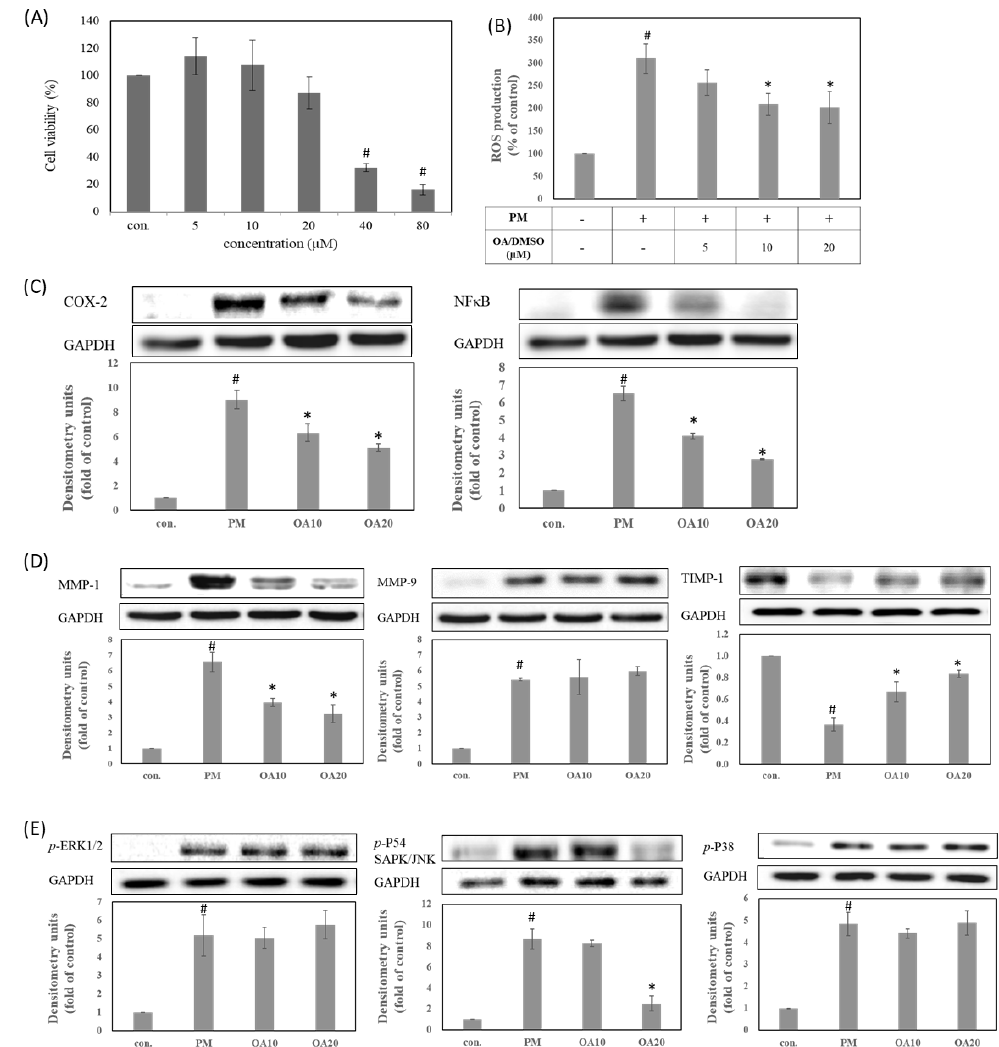
Figure 1. Oleanolic acid inhibits protein expression related to inflammation and aging in PM − induced keratinocytes damage through the ROS/MAPKs pathway. ( A ) Cell viability, ( B ) ROS production, ( C ) COX-2 and NF- κ B, ( D ) MMP and TIMP protein expression, and ( E ) phosphorylation of MAPKs. # represents p < 0.05 when compared with negative control. * represents p < 0.05 when compared with PM-induced control.